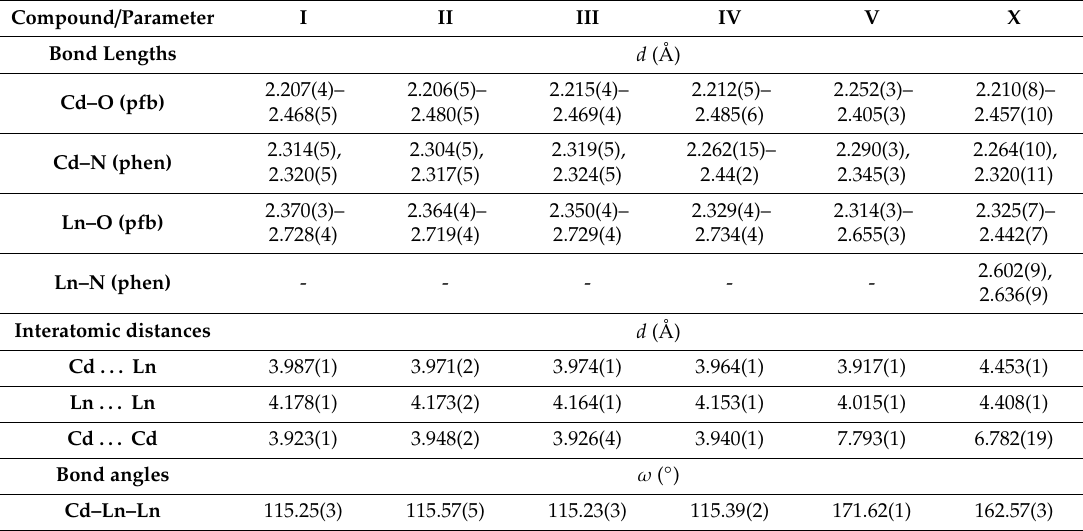
Table 1. Selected bond lengths, the shortest interatomic distances d (Å) and angles ω ( ◦ ) in structures I – V,